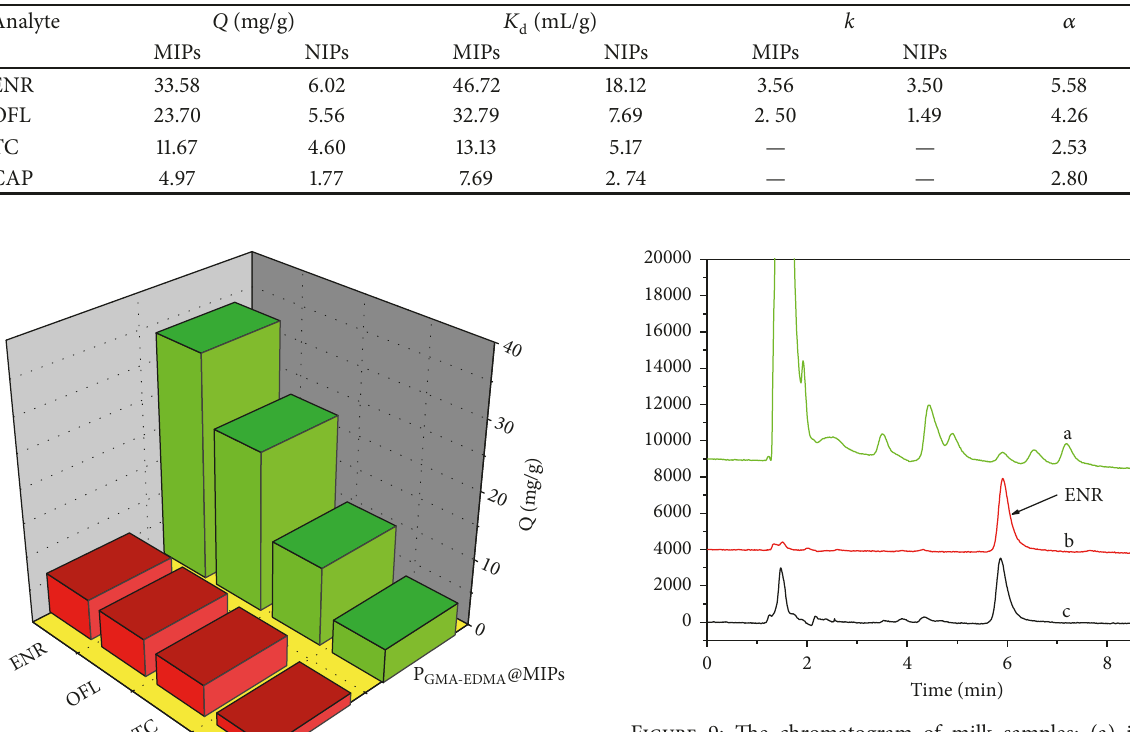
@MIPs treatment, and (c) - EDMA